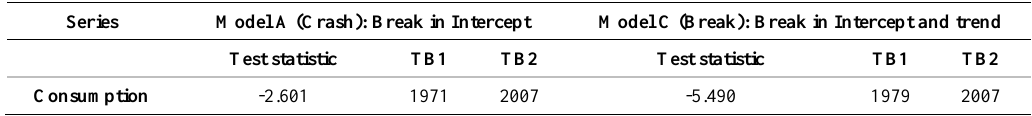
Table 3. Results of Lee and Strazicich (2003) unit root test with two structural breaks (Model A and Model